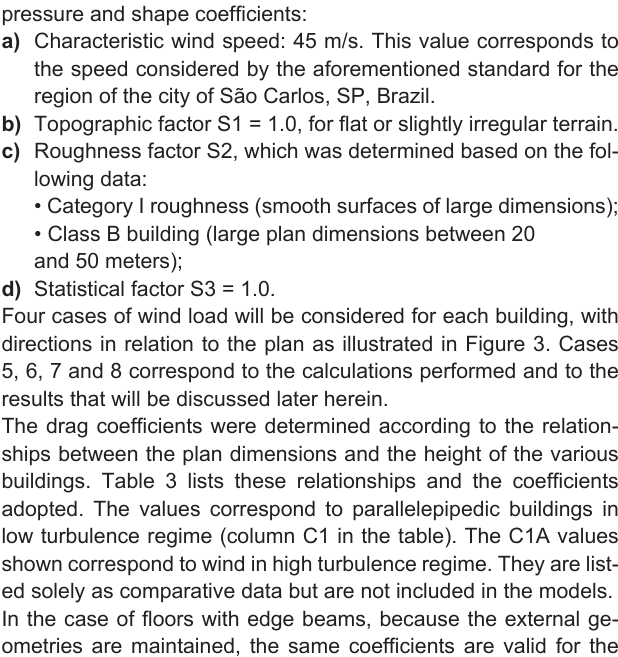
Figure 3 – Direction of wind